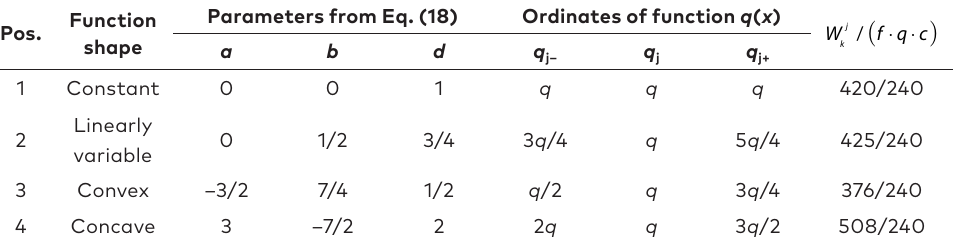
Table 2. Geometric characteristics of function q ( x )